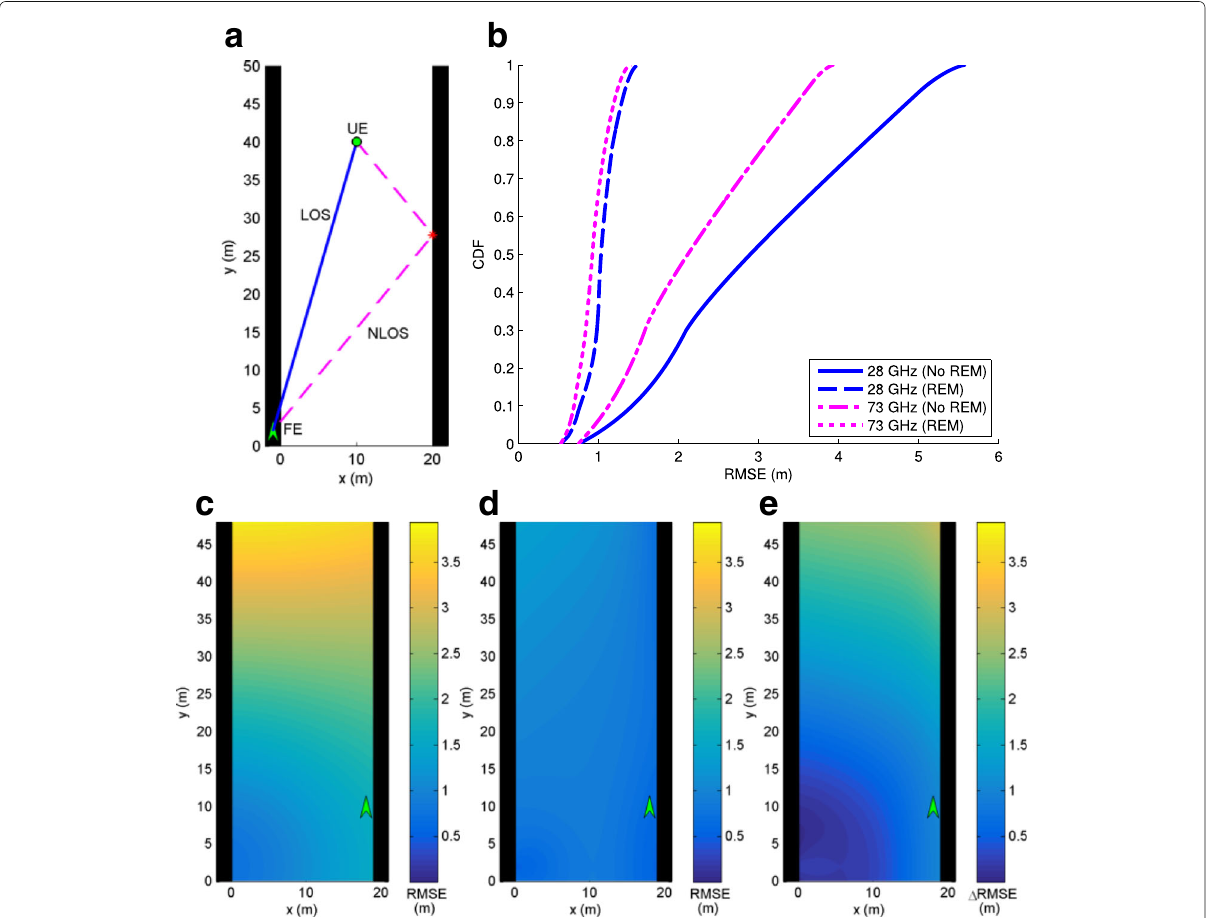
Fig. 6 a Urban canyon with one FE, one LOS path, and one NLOS path. b CDF of RMSE. c RMSE at 73 GHz without REM. d RMSE at 73 GHz with REM. e Improvement in RMSE with REM at 73